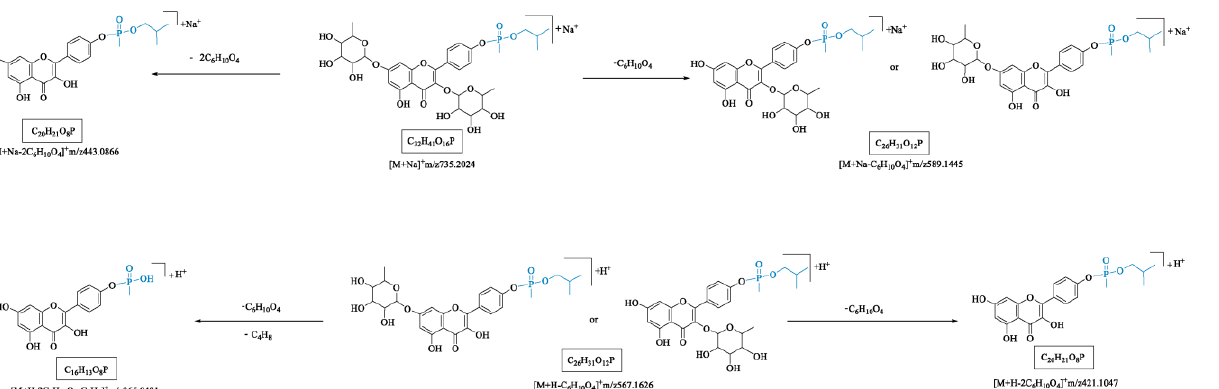
Figure 13. PIMS of m / z 735.2024 ( A ) and m / z 567.1626 ( B ) from the reference of compound 7 . The blue sign was used to mark the precursor ion.